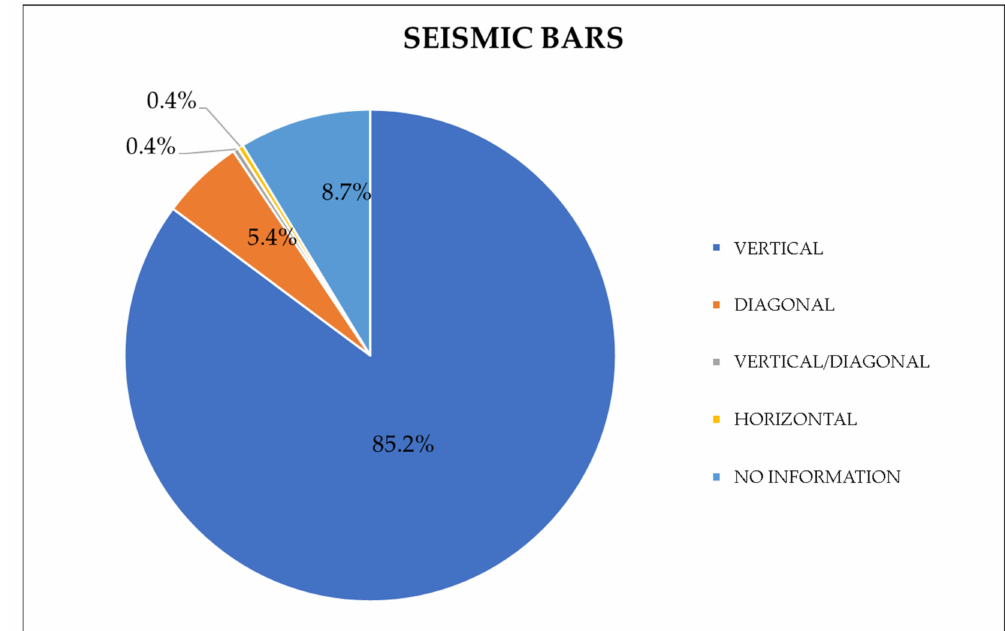
Figure 9. Historical classification of seismic bars.